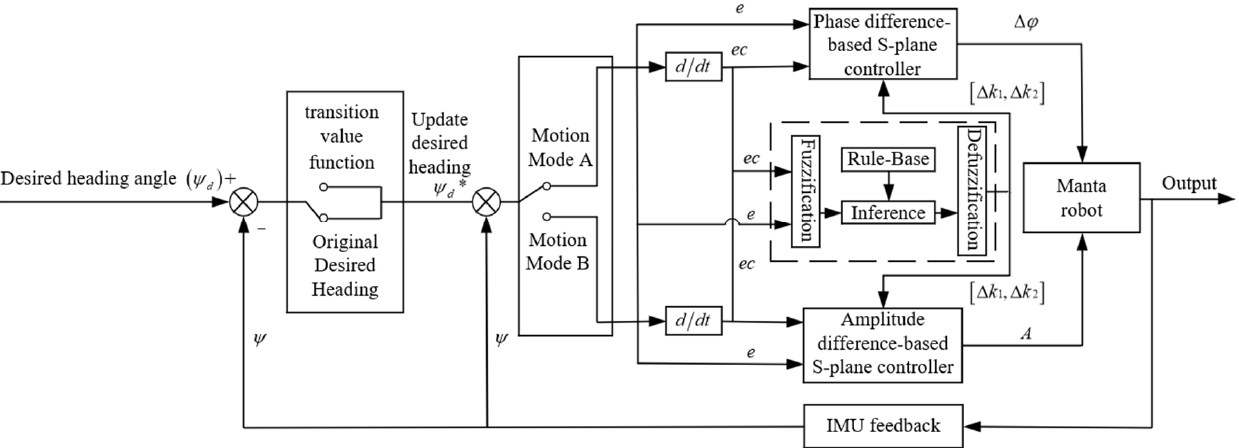
(cid:48) is ' ψ is the d